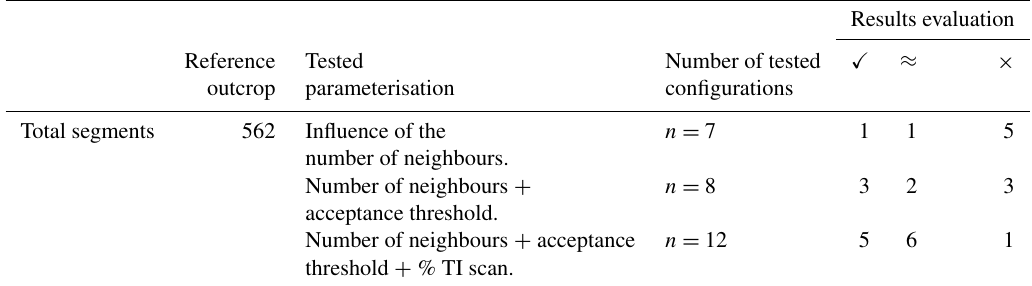
Table 3. Comparison between the total amount of segments interpreted in the reference outcrop and in the different sets of simulations (tested parameterisation). Evaluation of the results in terms of satisfactory ( (cid:88) ), acceptable ( ≈ ) or non-satisfactory ( ×